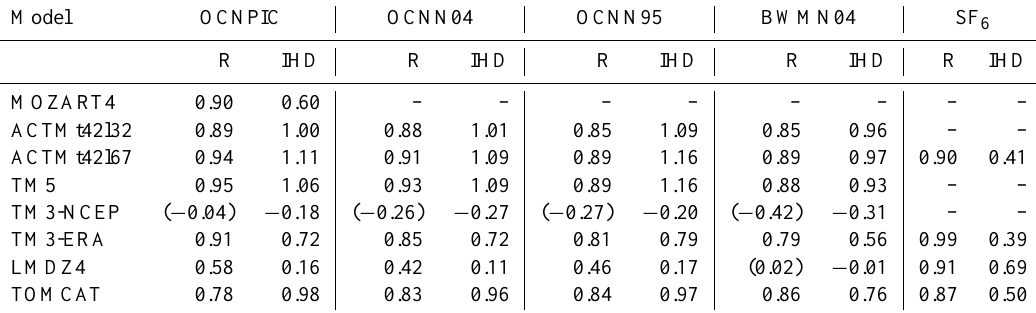
Table 8. Correlations of modelled and observed zonal mean meridional gradients for different flux scenarios (mean 2006–2009). Also shown are the inter-hemispheric differences (IHD) calculated as the mean of values for all background sites north of 20 ◦ N minus the mean of all values for sites south of 20 ◦ S. The observed IHD for N 2 O and SF 6 were 1.44ppb and 0.36ppt, respectively. R values in brackets were not significant at the 95% confidence